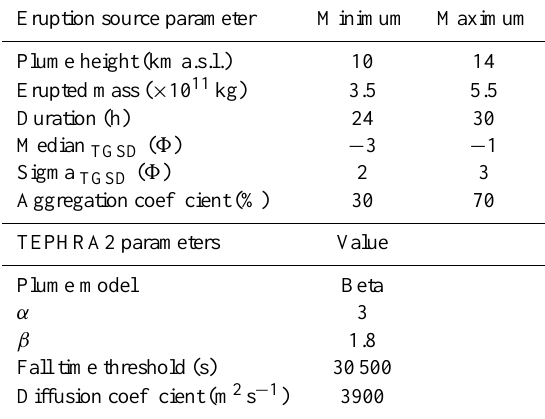
Table 8. Eruption source parameters used for the modeling with TEPHRA2 as derived from observations and inversions of field data (Pistolesi et al., 2015; Bonadonna et al., 2015a, b). Eruption source